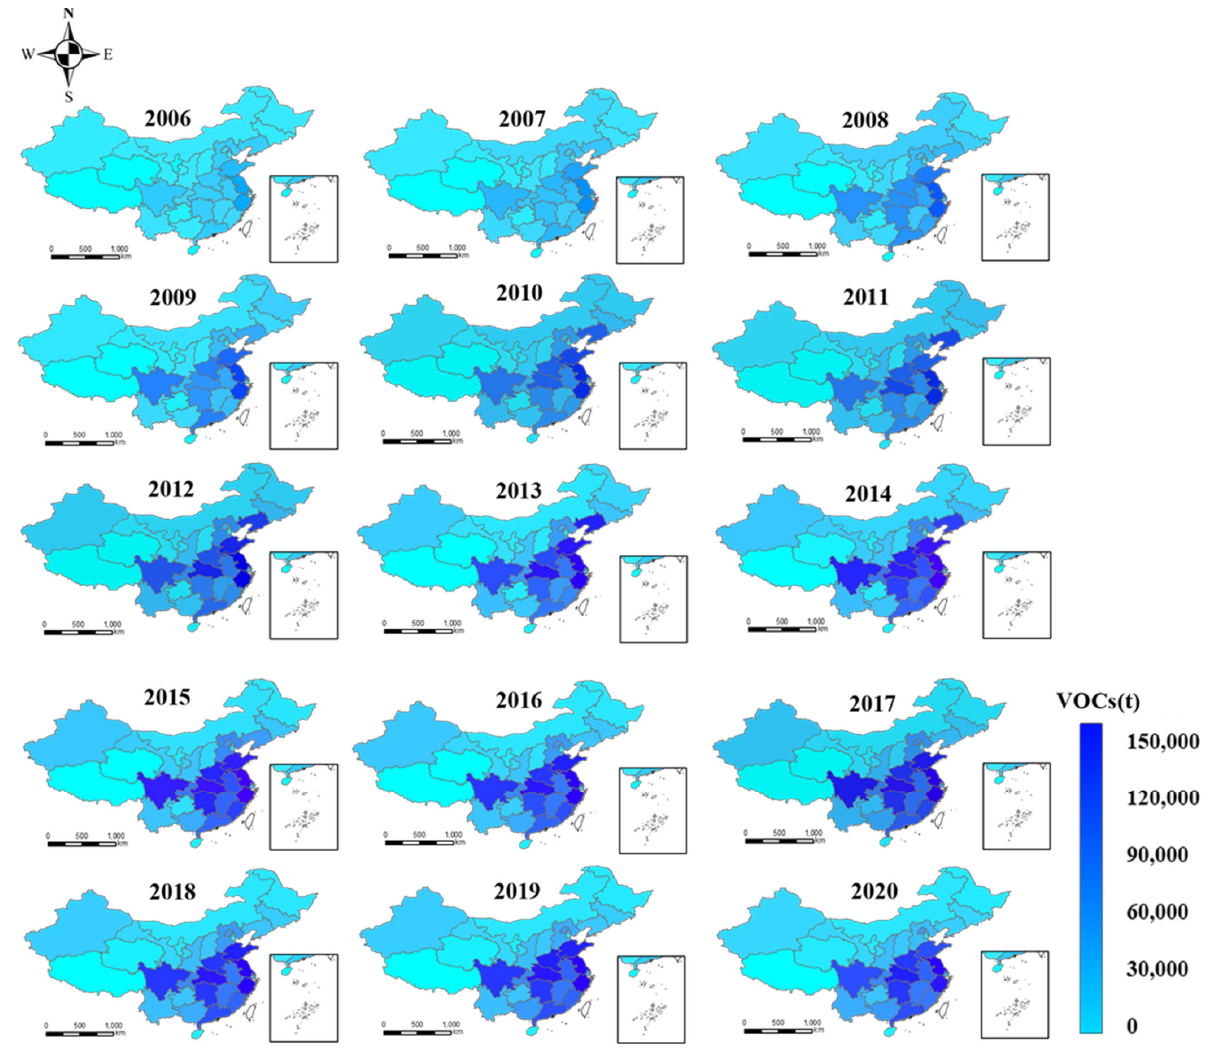
Figure 1. Spatial and temporal distribution of building industry VOCs emissions by province and city in China 2006–2020.